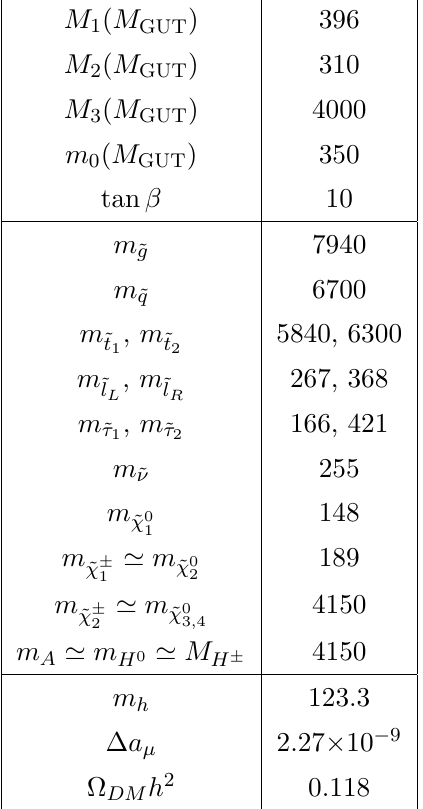
Table 1 . Complete spectrum for a benchmark point that satis(cid:12)es all existing constraints. All masses are in GeV.